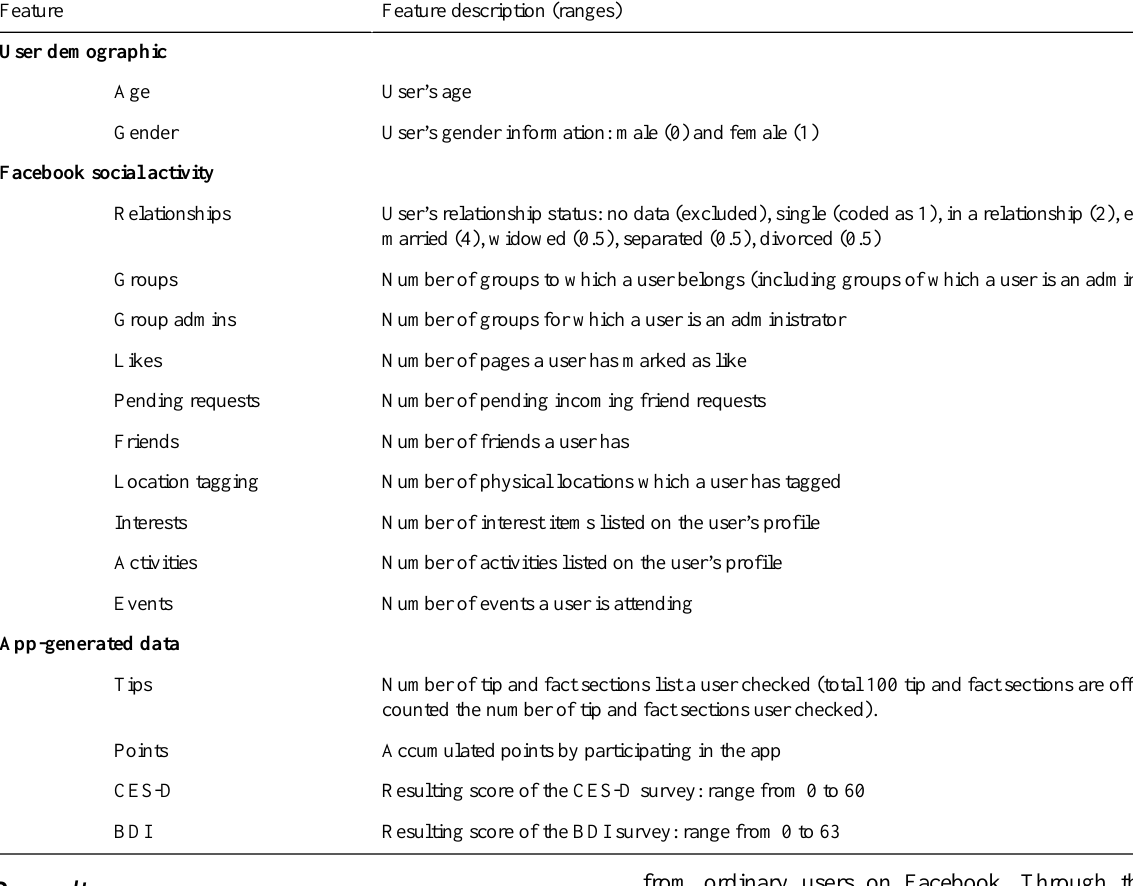
Table 1. Facebook social activity and app-generated features.